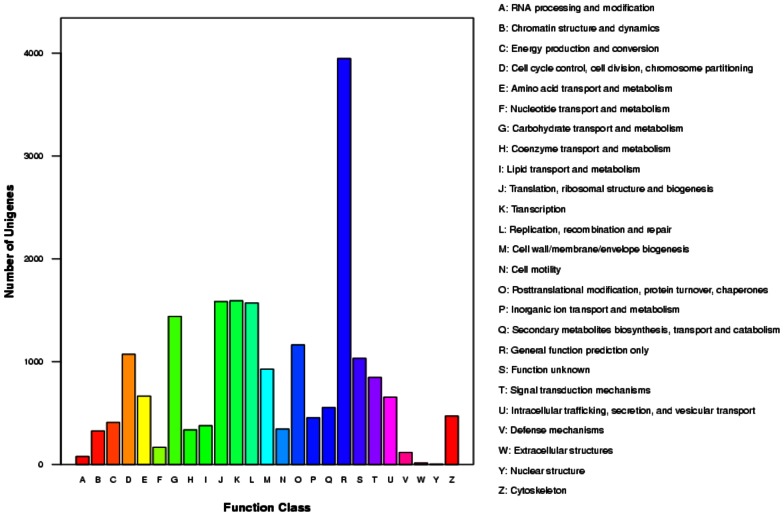
Histogram presentation of Clusters of Orthologus Groups classification of 8,837 known protein annotated unigenes.Each bar represents the number of unigenes classified into each of the 26 COG functional categories.